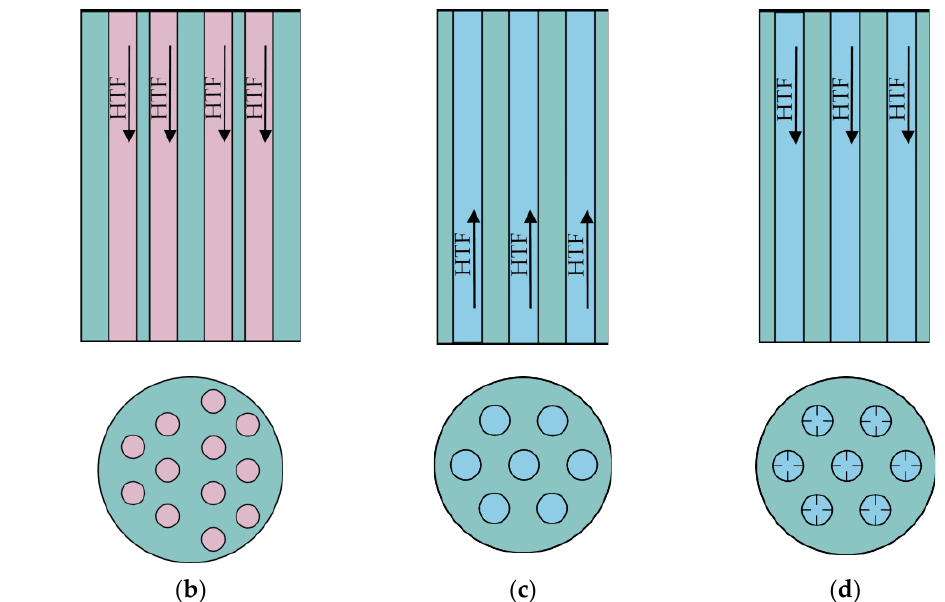
Figure 7. Vertical multi-tube arrangements; ( a ) Case MTV-T-M; ( b ) Case MTV-B-AT-M; ( c ) Case MTV-B-S; ( d ) Case MTV-T-IFT-S.